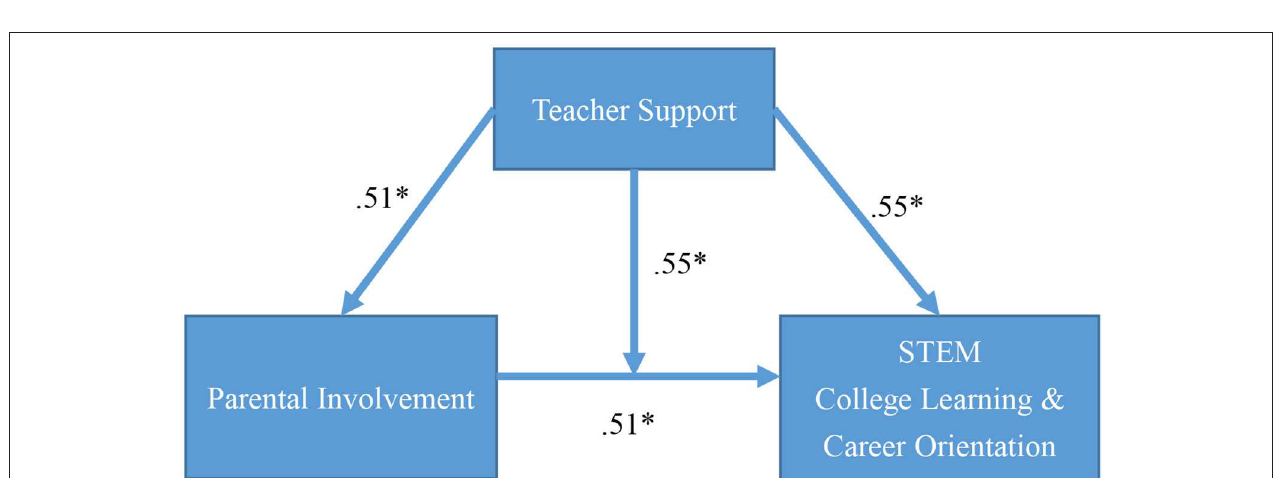
FIGURE 1 | The relationships between parental involvement, STEM activity engagement, and STEM college learning and career orientation by using a moderator analysis. * p < 0.05.